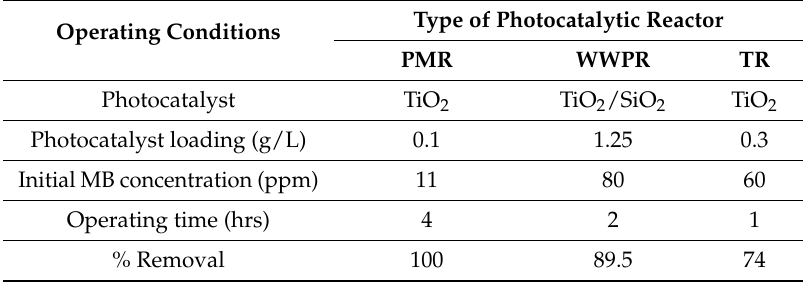
Table 6. The e ff ect of PMR, WWPR, and TR on MB removal at di ff erent operating conditions.